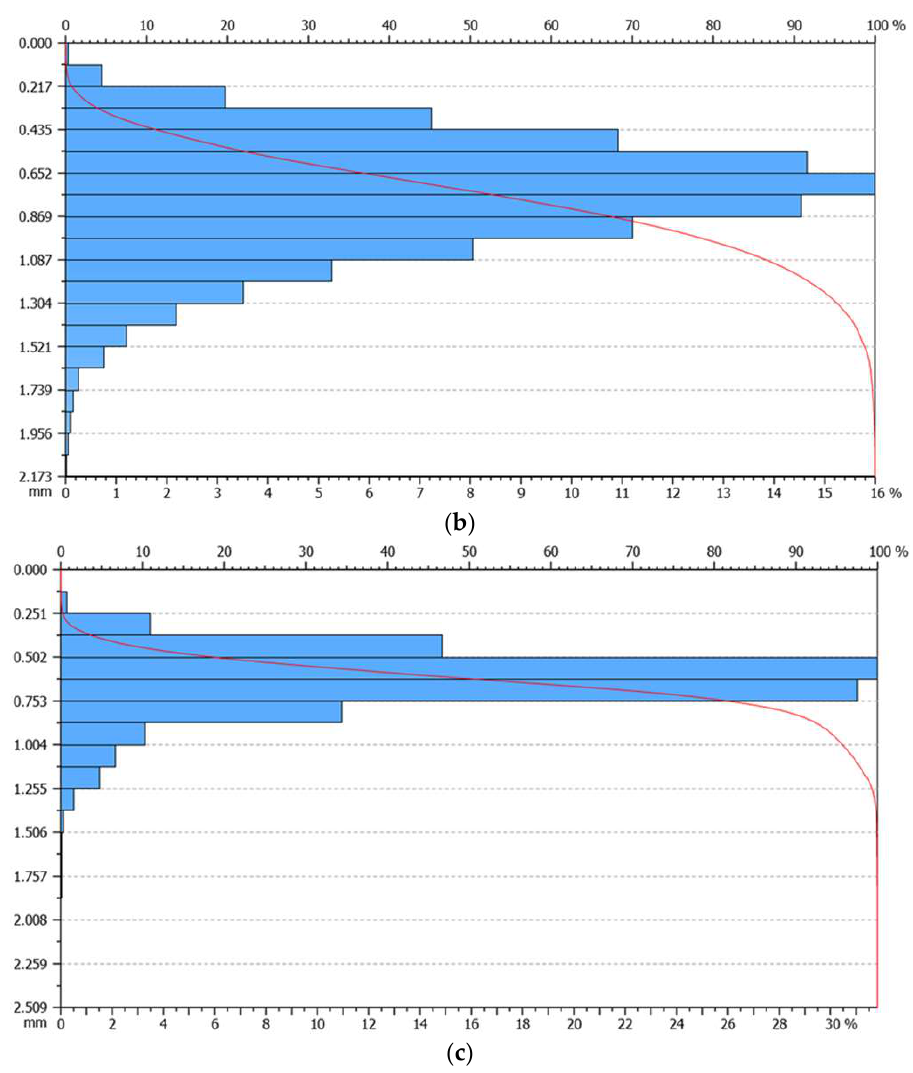
Figure 6. Abbott-Firestone curve for concrete surfaces: unprepared ( a ), sanded ( b ) and grinded ( c ).